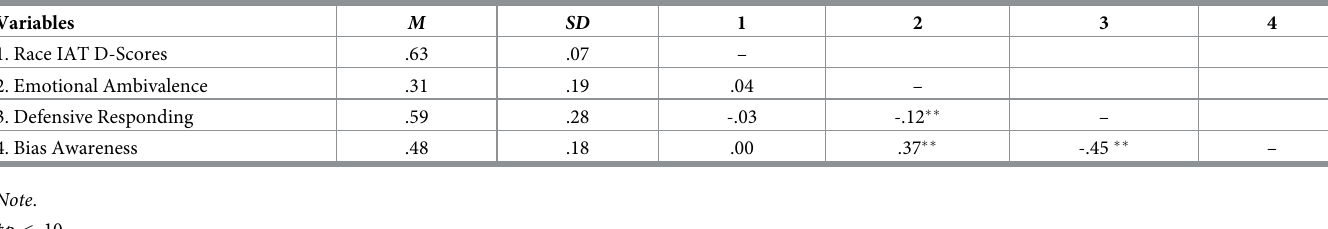
Table 1. Mean, SD, and correlations between all continuous variables